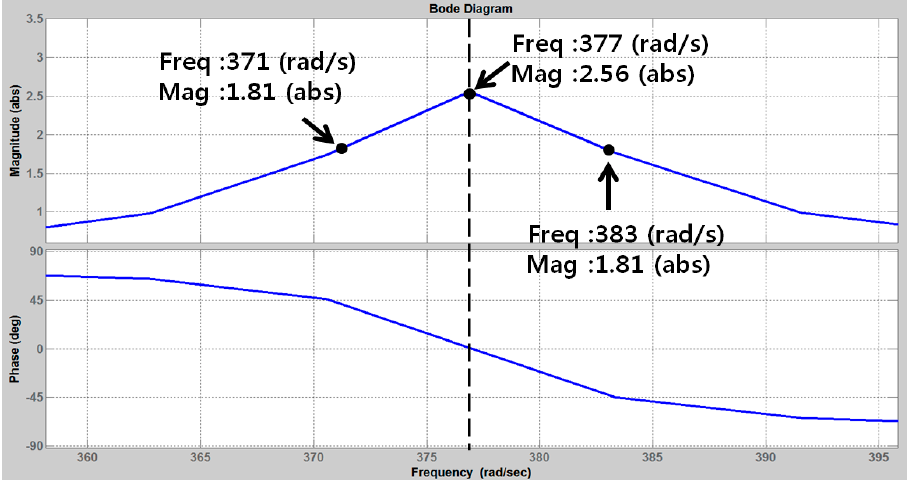
Figure 10. Consideration of the compatibility between the bandwidth of quasi PR control and min-max threshold values of the PLL limiter: Zoom in Bode plot of the quasi PR transfer function near the operating frequency.